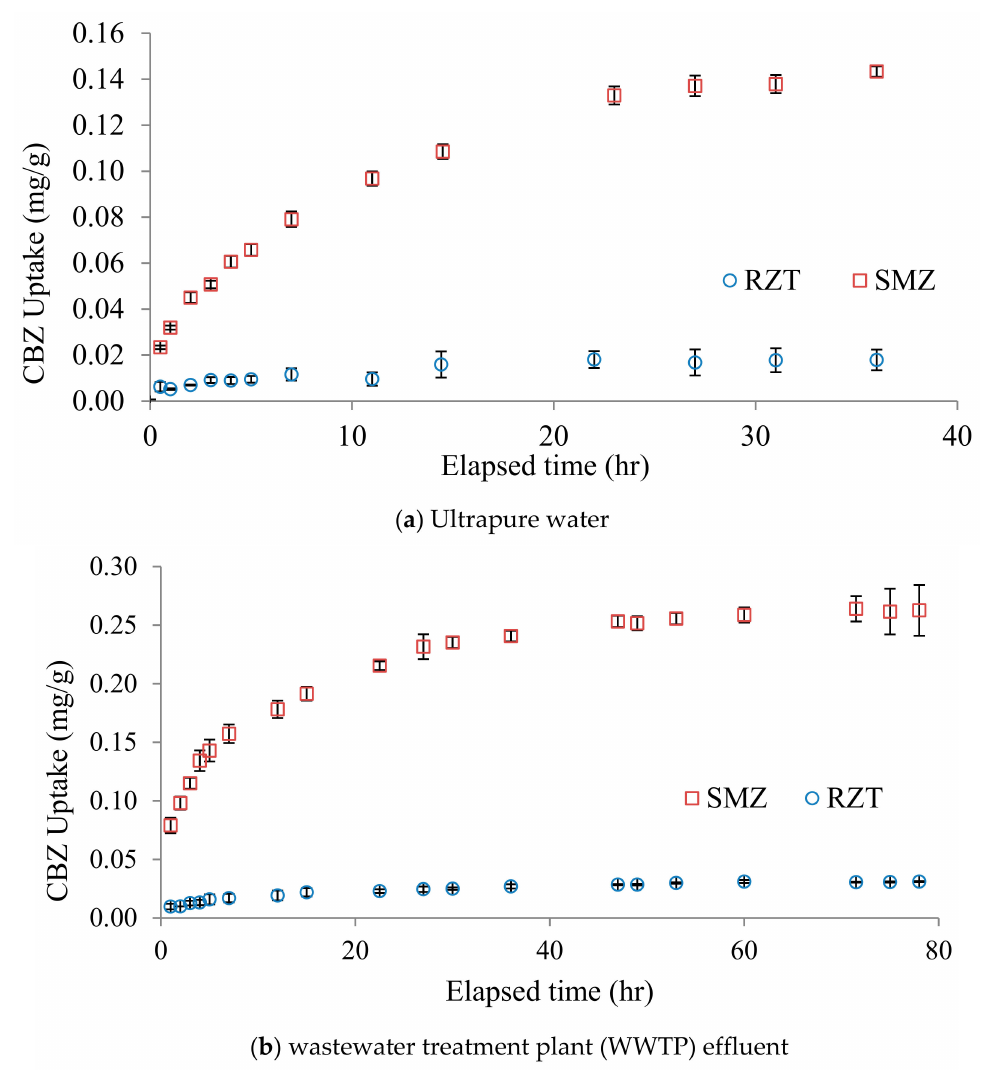
Figure 5. The kinetics of CBZ uptake by RZT and SMZ using ( a ) ultrapure water and ( b ) WWTP